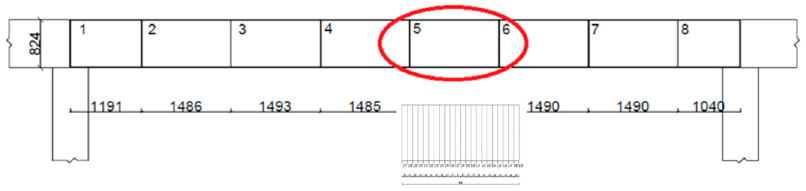
Figure 5. The beam’s most loaded part and the additional 22 measuring lines.